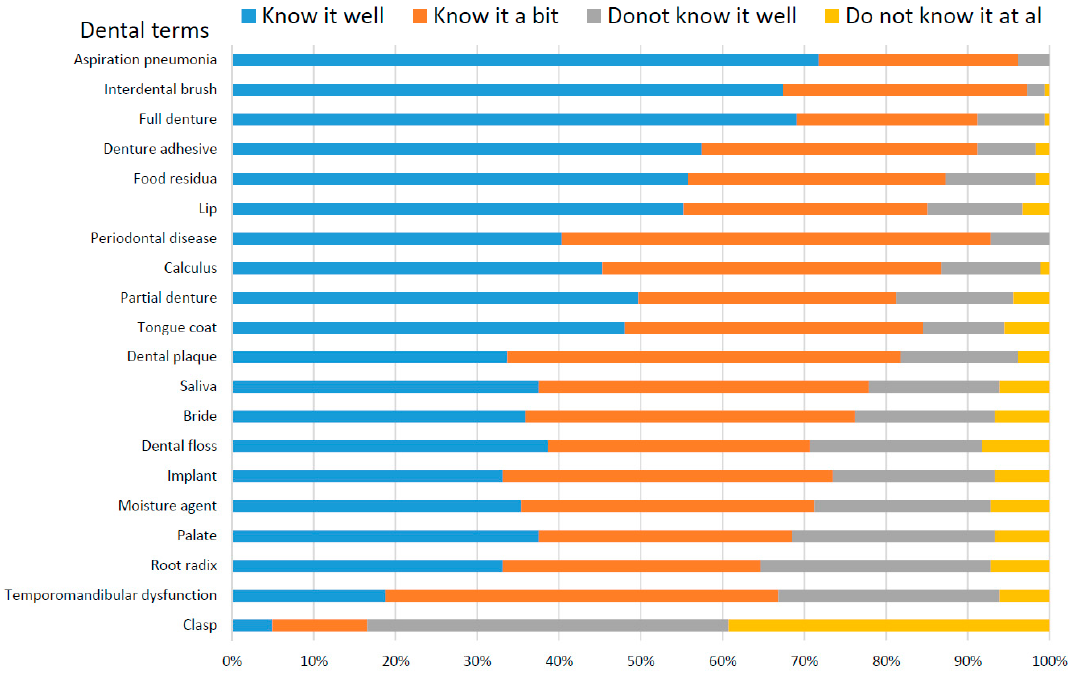
Figure 1. Score distribution of caregivers’ understanding of dental terms.